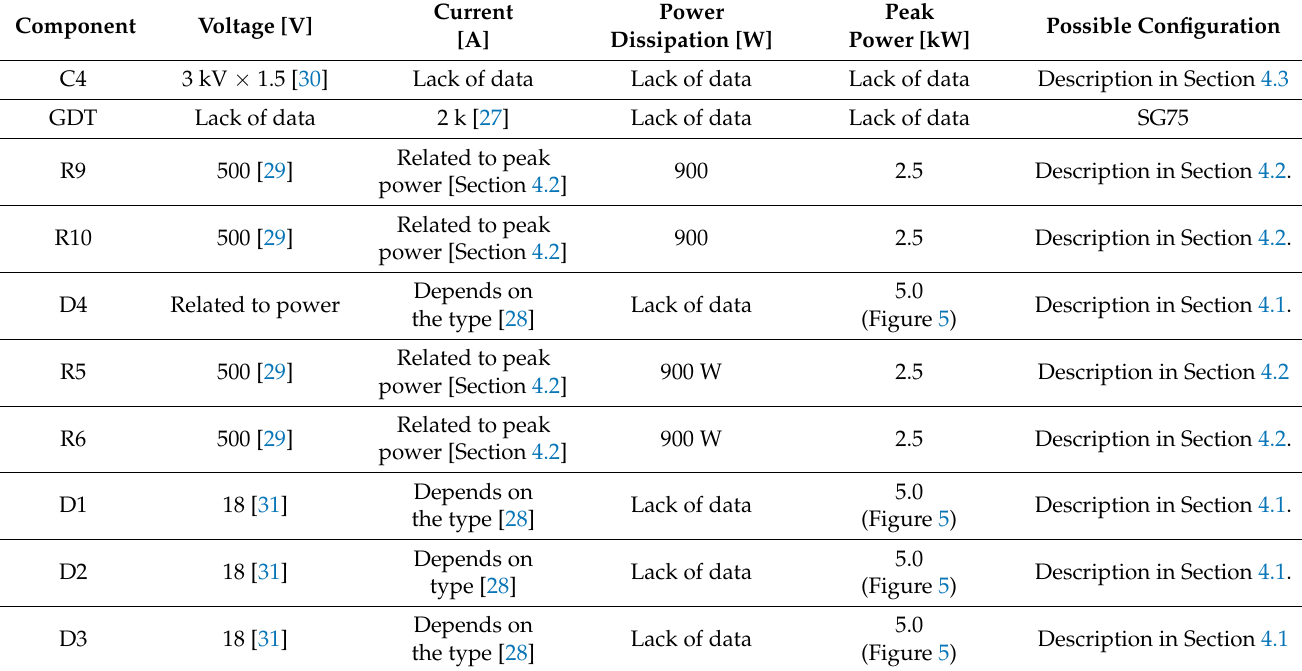
Table 1. Component